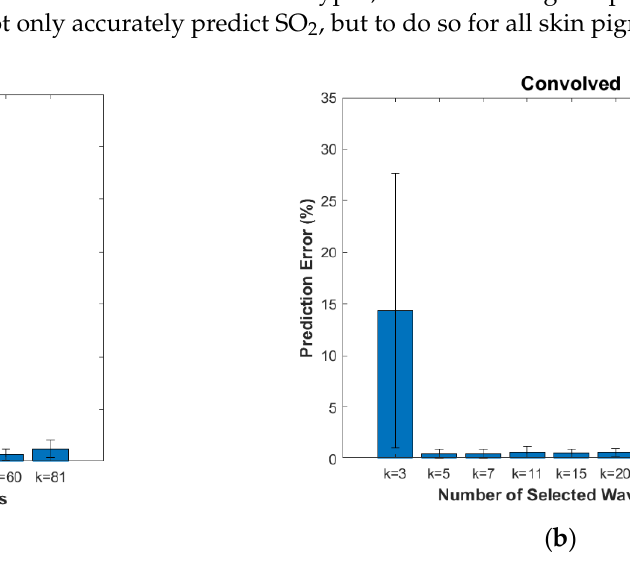
Figure 6. Mean prediction error values for each number of selected wavelengths along with one- standard-deviation error bars for the ( a ) ideal case and the ( b ) convolved case. Values are computed from the entire Monte Carlo validation dataset.